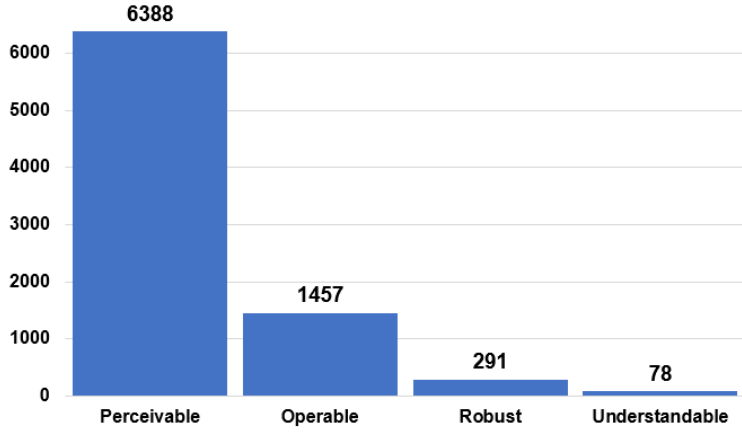
Figure 3. Web accessibility principles according to WCAG 2.1 .